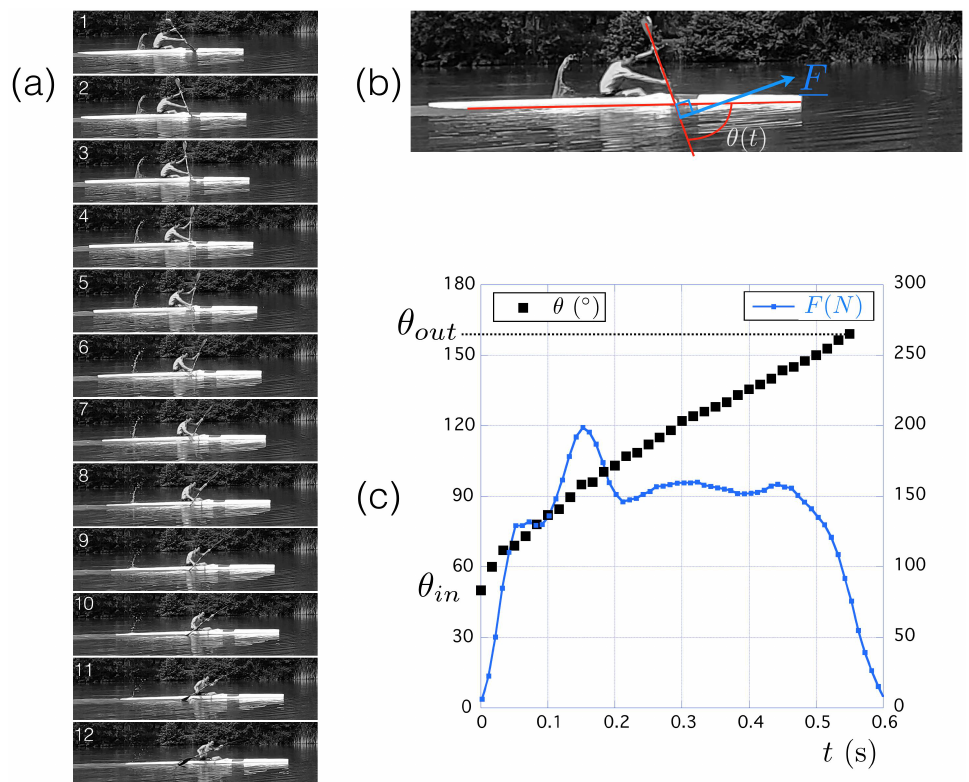
Figure 8. ( a ) Time sequence of a single paddling stroke performed by Athlete A1. The time lapse be- tween each image is ∆ t = 0.05 s. ( b ) Definition of the paddle angle θ and the normal force F . ( c ) Time evolution of the paddle angle θ (black squares) and the normal force intensity F (blue